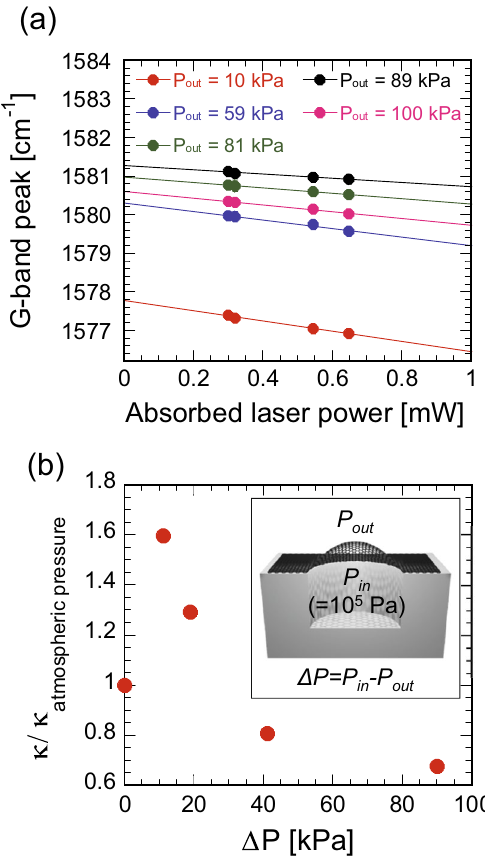
Figure 4. ( a ) Raman G band peak positions of the graphene drum (DEVICE 1) obtained with four different laser powers (0.71, 0.75, 1.27, and 1.52 mW) at various pressures P out . ( b ) Change in the thermal conductivity with respect to the pressure difference (cid:31) P = P in − P out . Values are normalized by that at atmospheric